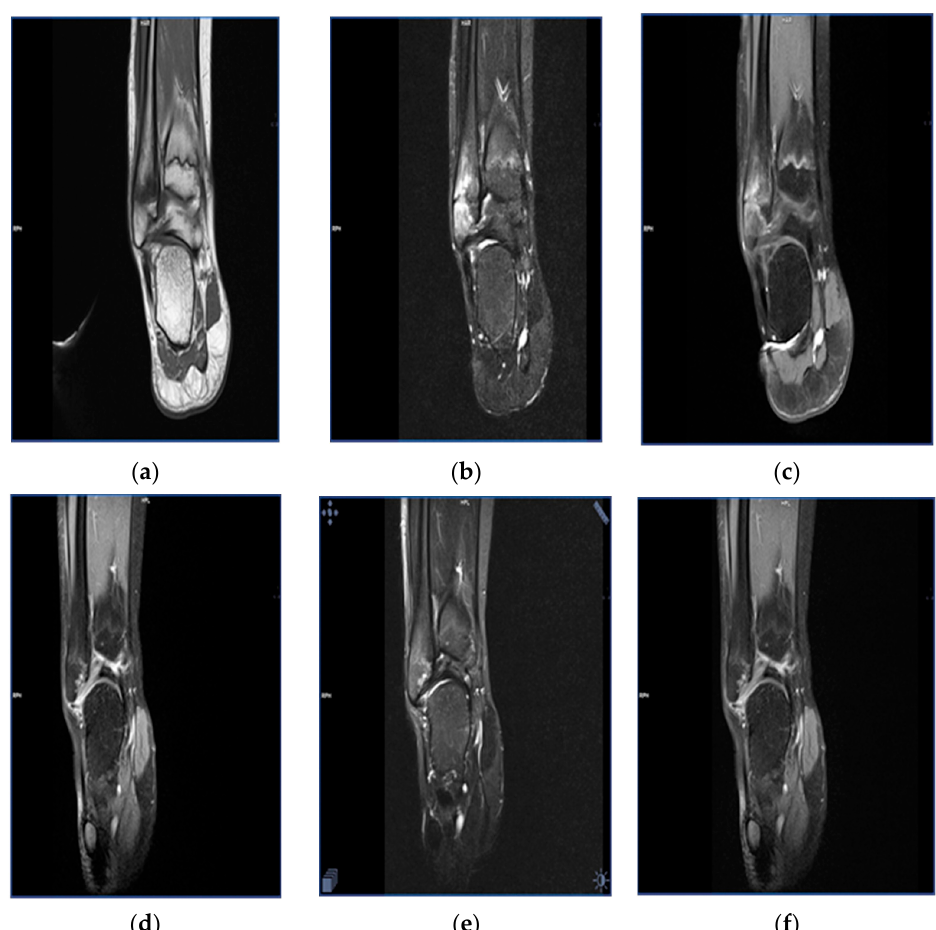
Figure 3. Magnetic resonance images in a 13-year-old female patient with bone marrow edema within the head of the fibula. Status before treatment: T1-weighted sequence ( a ), T2-weighted sequence ( b ), T1-weighted sequence with contrast enhancement ( c ). Status after a 15-month follow-up, with regression of the bone marrow edema: T1-weighted sequence ( d ), T2-weighted sequence ( e ), T1-weighted sequence with contrast enhancement ( f ).